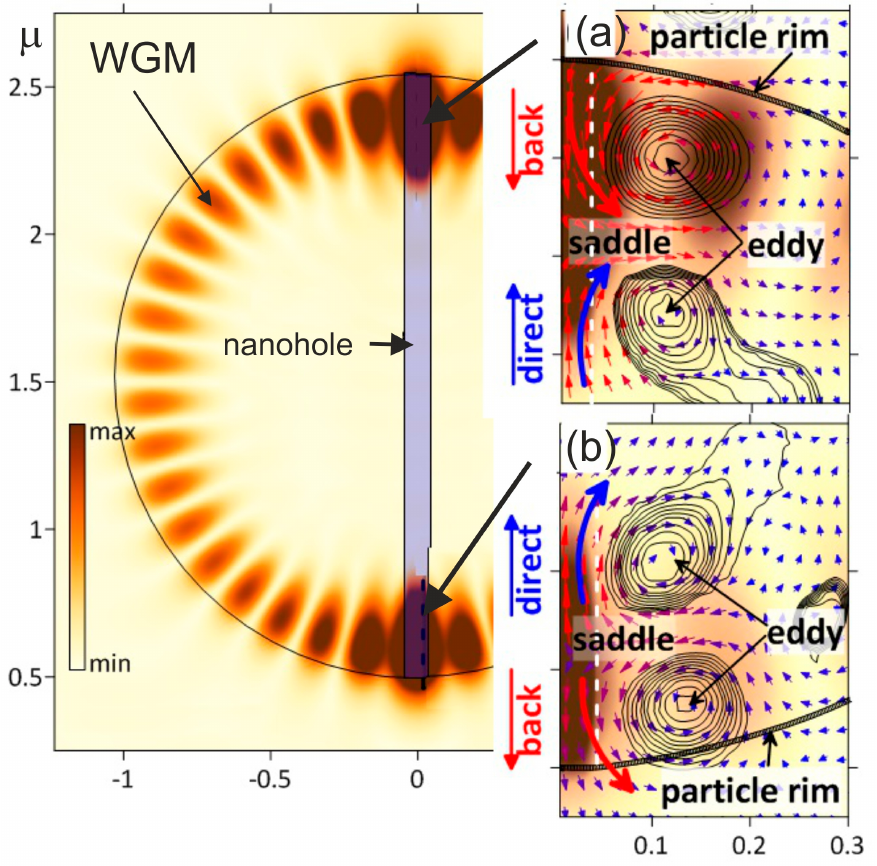
Figure 5. Direct and back energy flow structures in a nanohole structured spherical particle in the resonant mode. The radiation of a flat wavefront is incident from below. Adapted from [116].